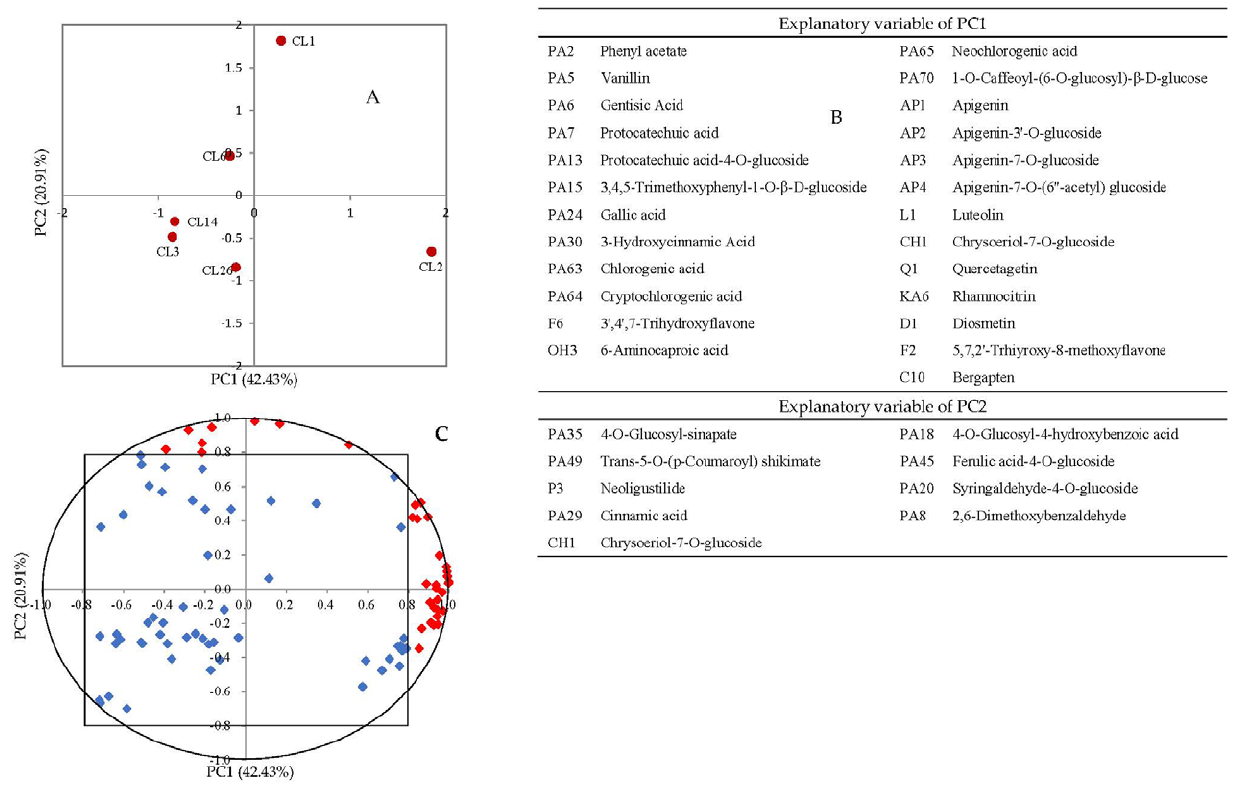
Figure 5. Principal component analysis of juice made from six celery cultivars (CL1, CL2, CL26, CL6, CL3, and CL14) using 87 different metabolites as variables. ( A ) Projection of cultivars; ( B ) distribution of variables; ( C ) the explanatory variables (26 compounds) of PC1 and the explanatory variables (seven compounds) of PC2 (red diamond, load value > 0.8).